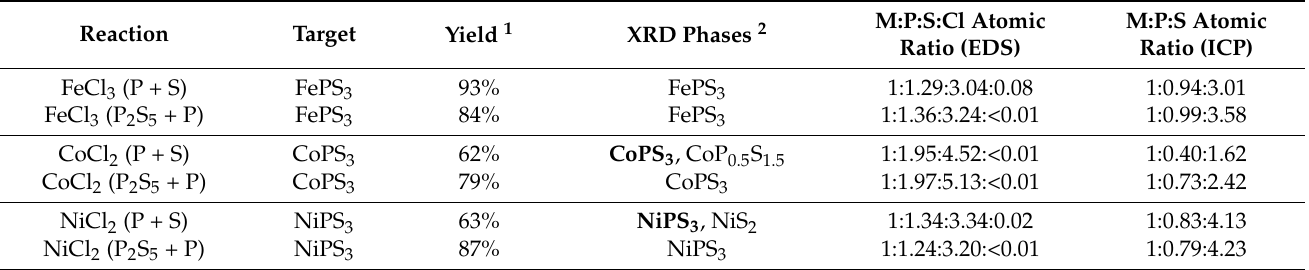
Table 1. Summary of MPS 3 reaction product yield, phase, and composition.